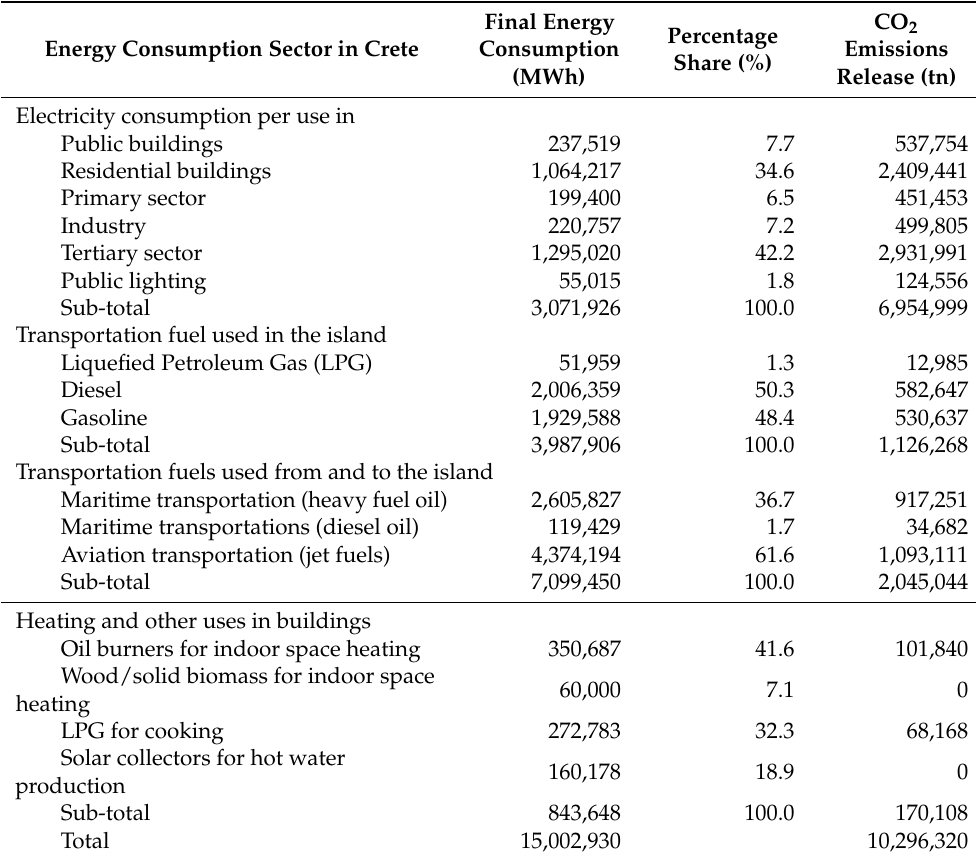
Table 1. Final energy consumption analysis in Crete Island, Greece (2019).